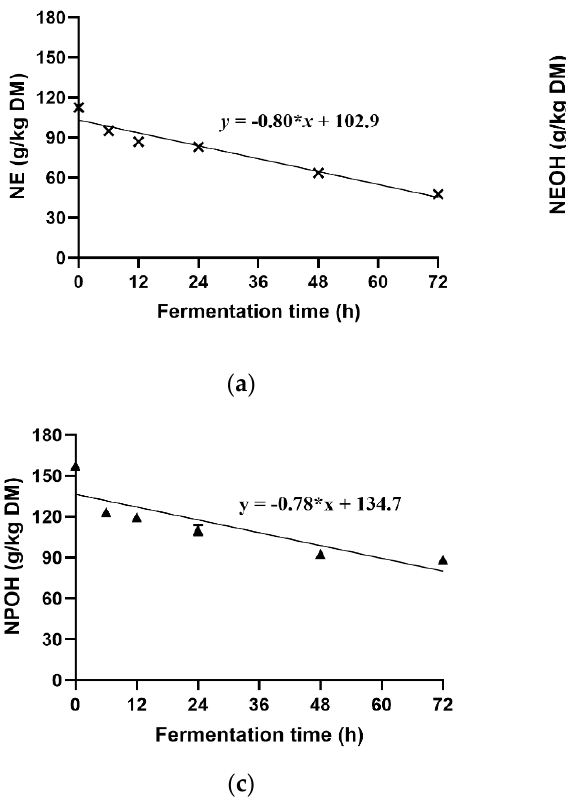
Figure 5. Variation of NE ( a ), NEOH ( b ), and NPOH ( c ) in culture fluids during 72 h incubation of grain-rich feed incubated in batch cultures of mixed rumen microorganisms. DM: dry matter; NE: nitroethane; NEOH: 2-nitroalcohol; NPOH: 2-nitro-1-propanol.